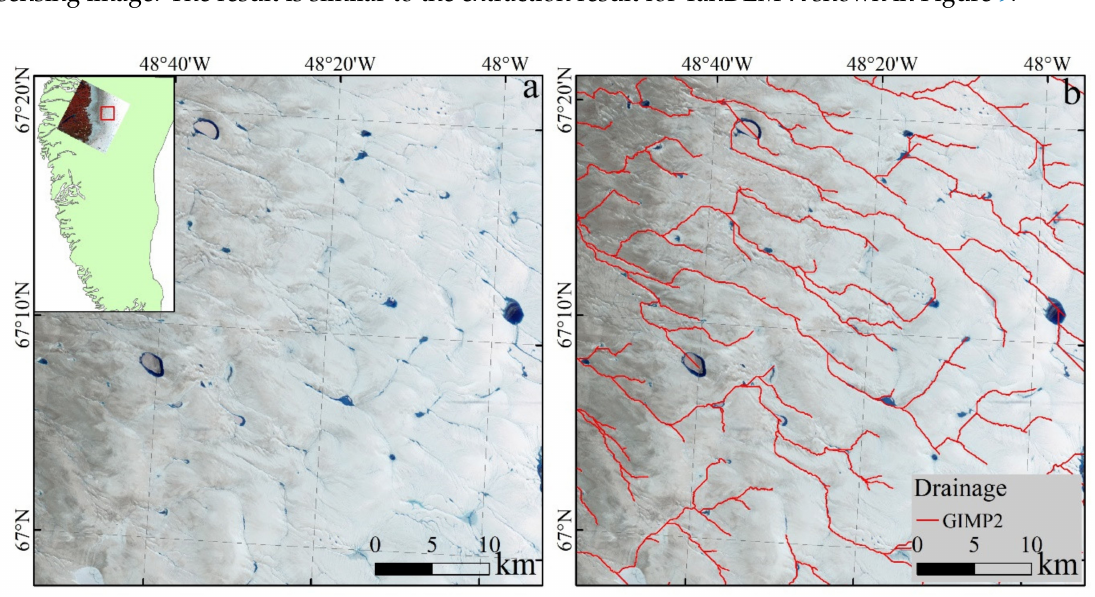
Figure 10. Verification of the GIMP2 river network extraction result. The basin name of the inset map is the southwest basin. Panel ( a ) is the distribution of the actual river network, and panel ( b ) is the river network extraction result for the GIMP2 product. The background image is from Landsat-8 and was acquired on August 6, 2014. River network information on the fused image is not obvious, so the fused image is